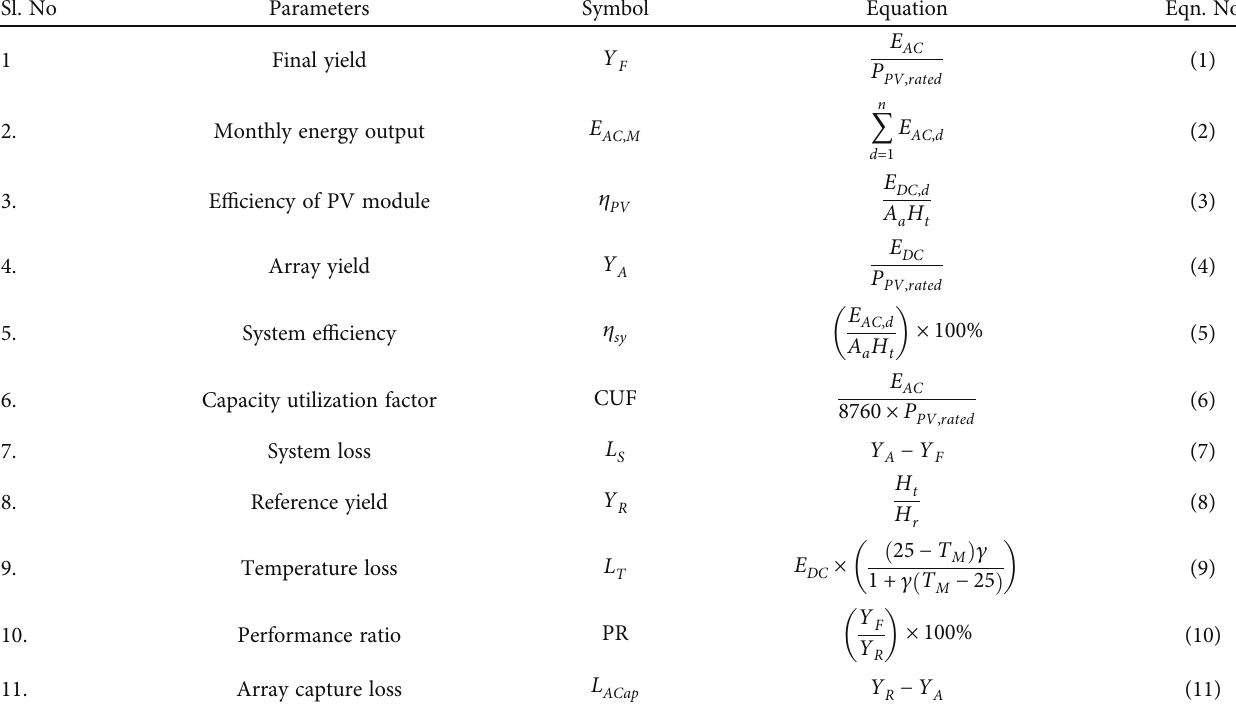
Table 3: Evaluation metrics for assessment.